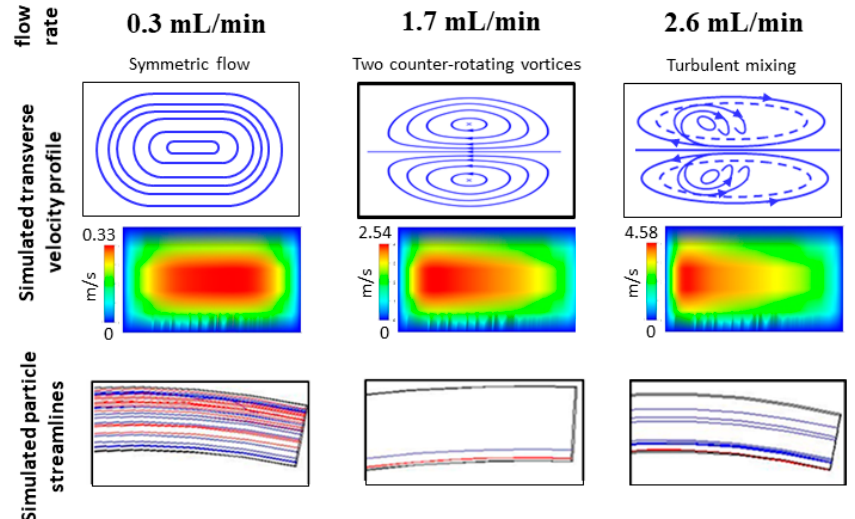
Figure 5. Simulation studies at three different fluid velocities show the spectrum of particle behaviors in the spiral microfluidic device. At 0.3 m/s, there are insufficient dean and inertial lift forces, so particles are not focused nor separated. At 1.7 m/s, the lateral Dean forces are slightly less than inertial lift forces, and this supports particle focusing and fractionation. At 2.6 m/s, Dean forces dominate, and particle streams are defocused due to lateral mixing.